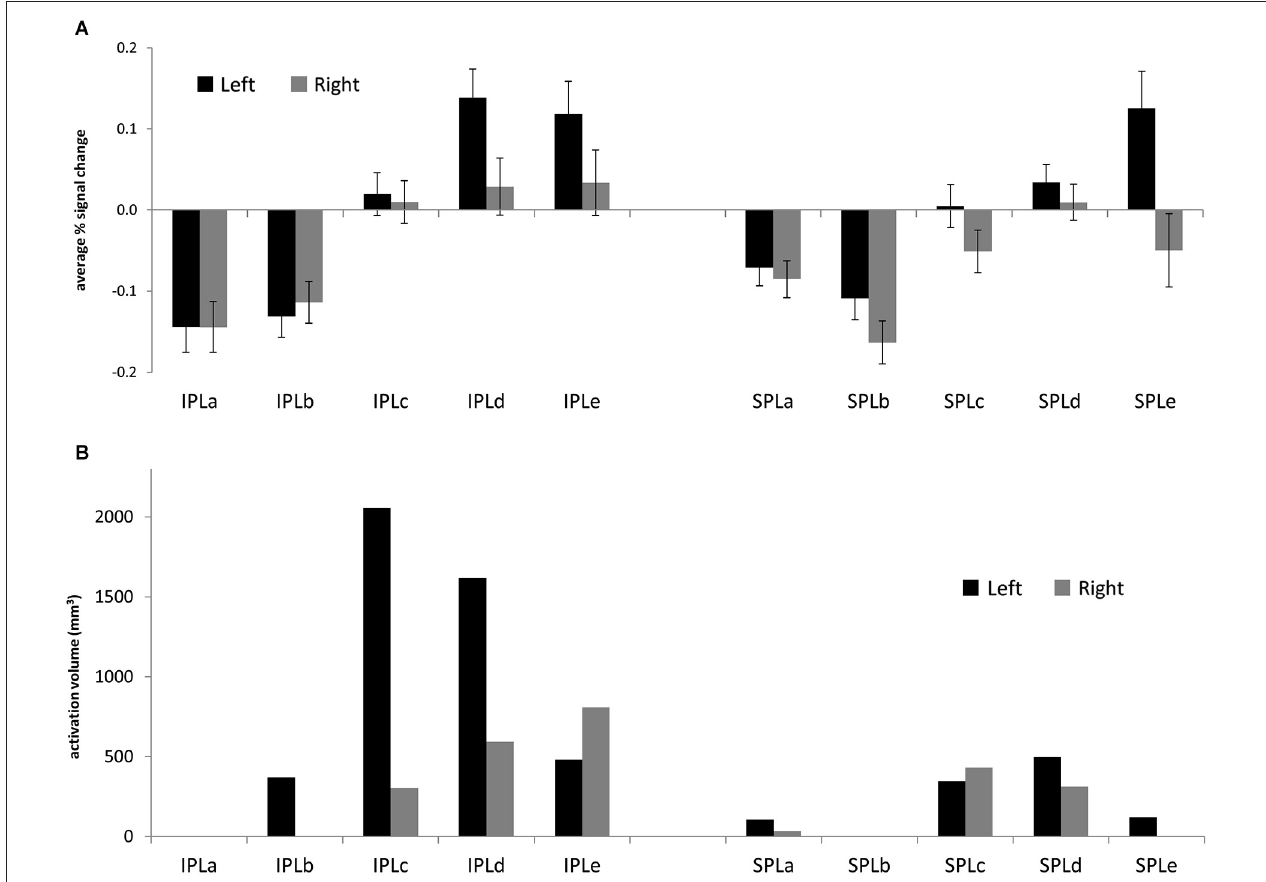
bars are standard error of the mean across subjects. (B) Volume of the Neurosynth forward inference map associated with reasoning, for each posterior parietal